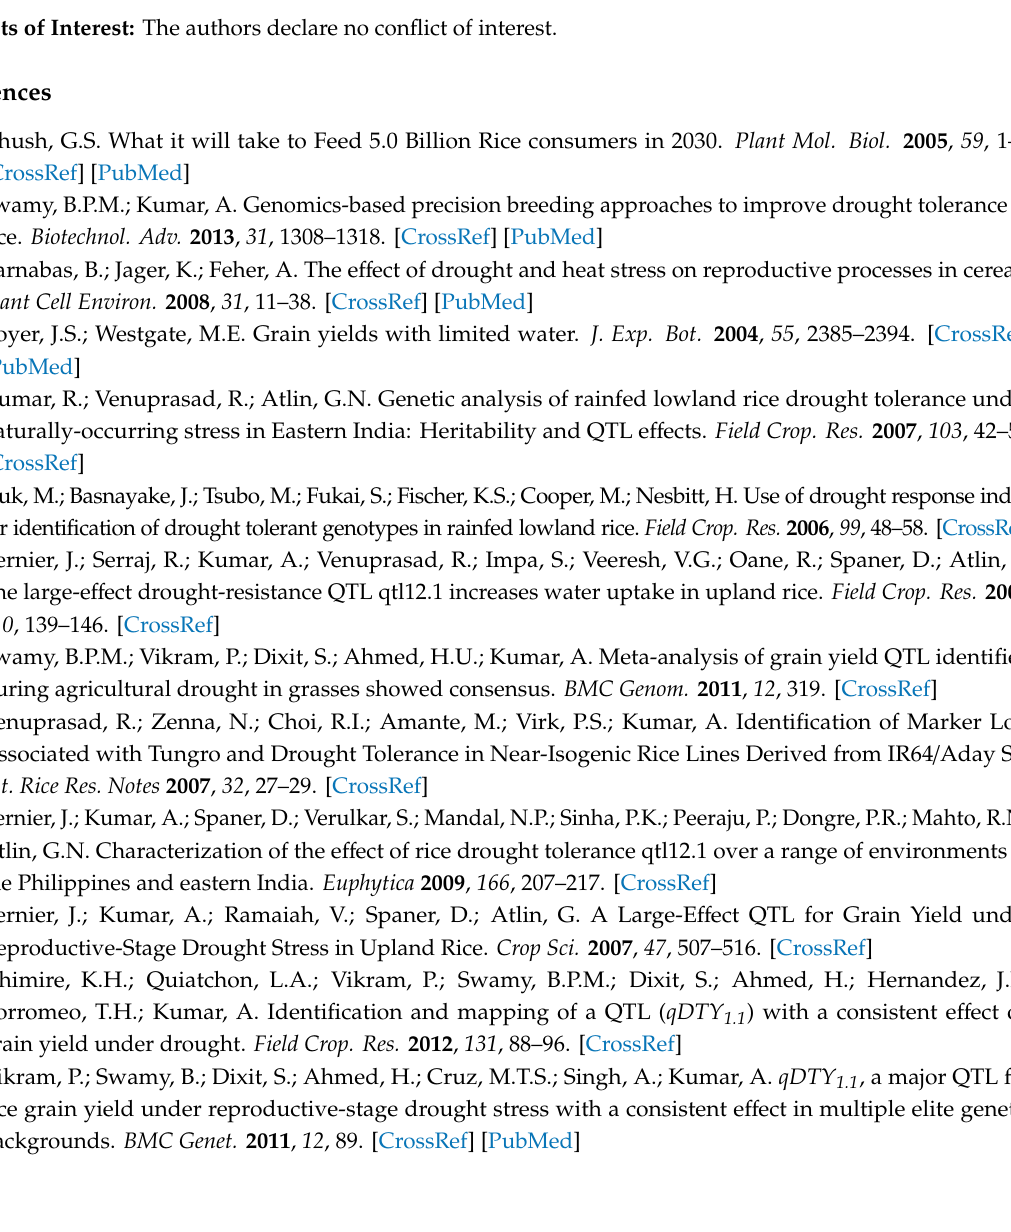
Table S1: Morphological and agronomical traits of Selected MRQ74 PLs under RS, Table S2: Morphological and agronomical traits of Selected MRQ74 PLs under NS, Table S3: Morphological and agronomical traits of Selected MR219 PLs under RS, Table S4: Morphological and agronomical traits of Selected MR219 PLs under NS, Table S5: Correlation between traits in MRQ74 PLs, Table S6: Correlation between traits in MR219